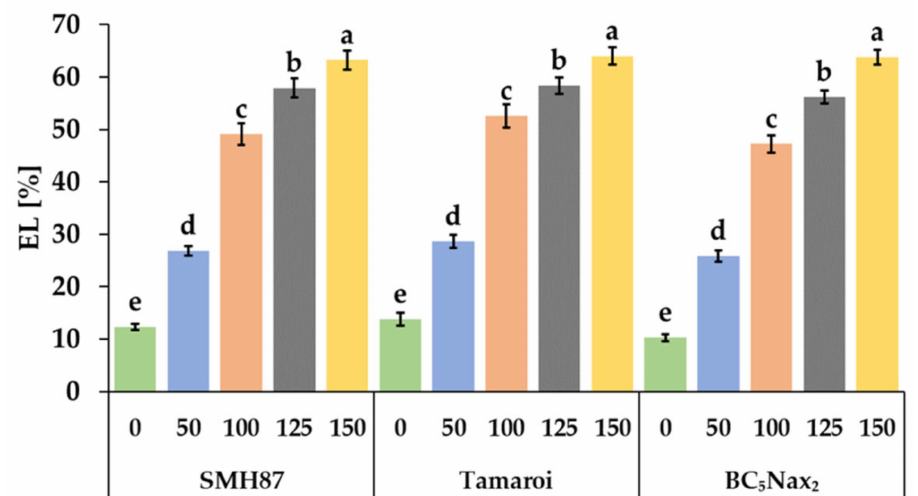
Figure 2. Effects of NaCl treatments (0, 50, 100, 125, 150 mM) on the electrolyte leakage (EL). The values represent means (n = 10) ± SE within each accession, and those marked with the same letters do not differ statistically according to multiple range Duncan’s test ( p < 0.05).